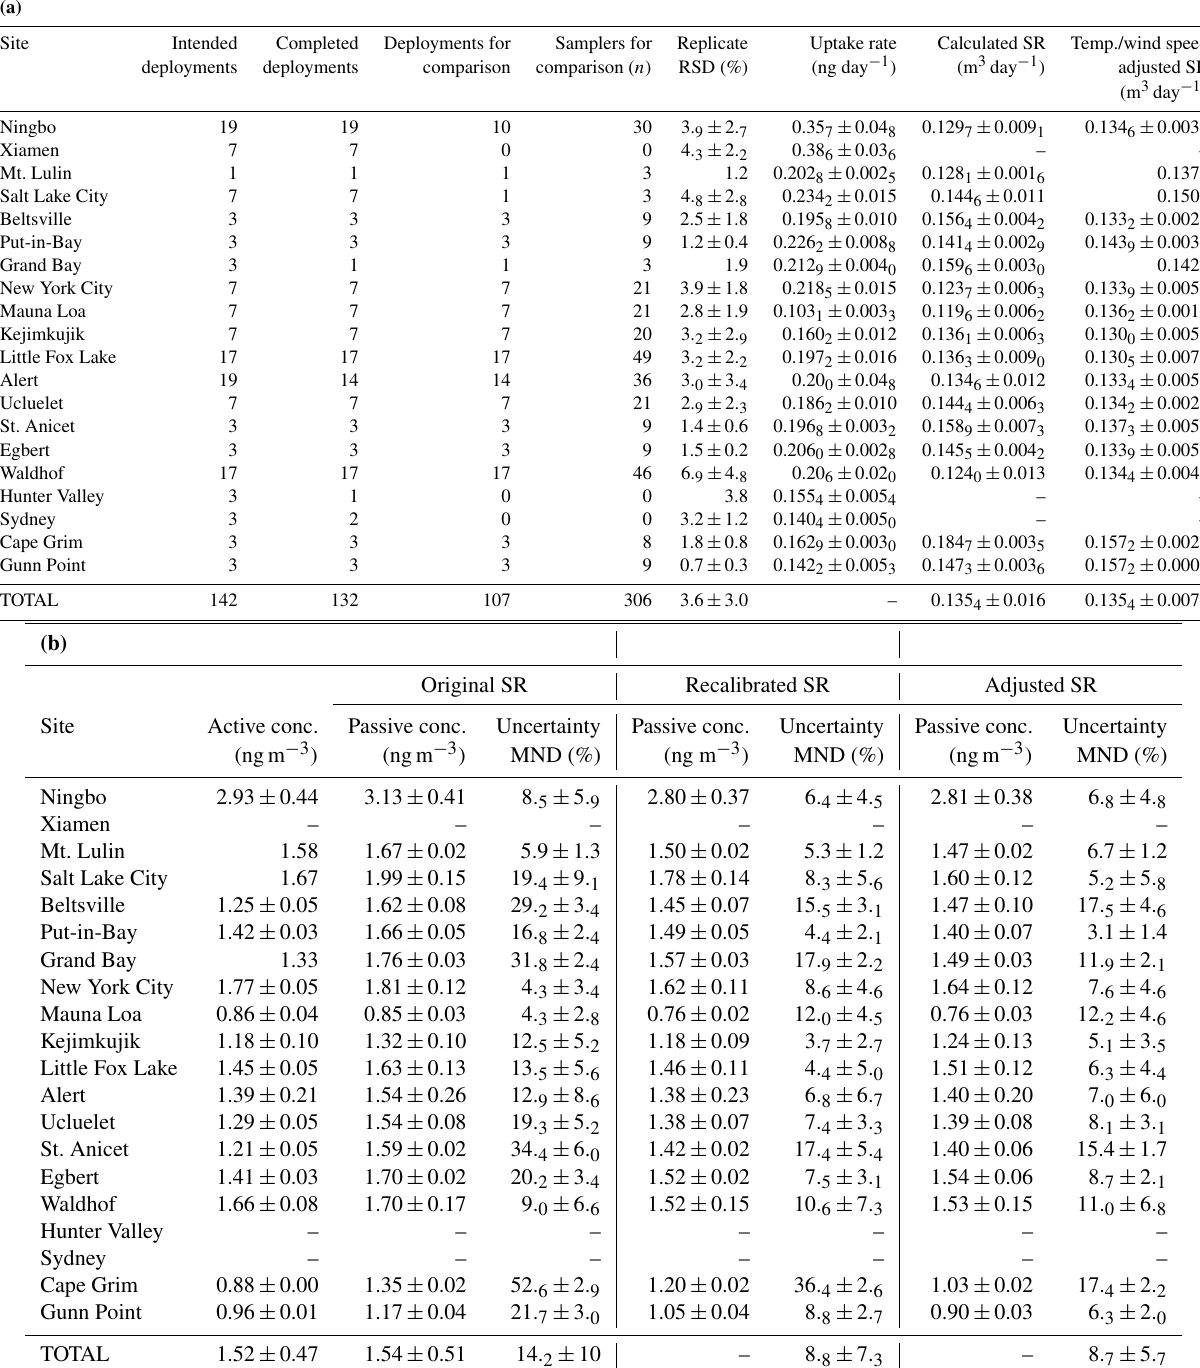
Table 1. Mean passive and active air sampler data at each sampling location. (a) Replicate relative standard deviation, uptake rate, original sampling rate (SR), recalibrated SR, and adjusted SR adjusted for the measured temperature and wind speed at each sampling site (Eq.